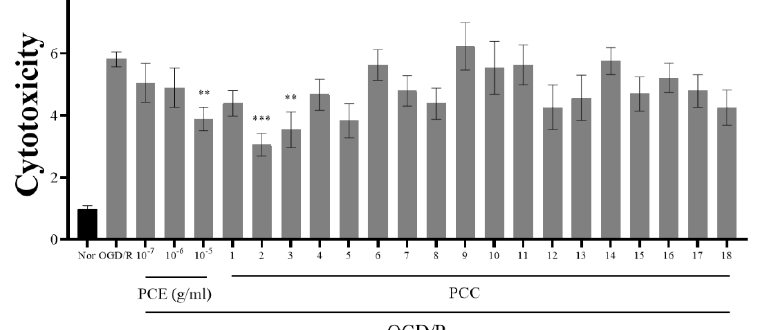
Figure 2. Reduced cytotoxicity due to PCE and PCCs from an assay of LDH release in primary neuron cells. Primary cultured mouse neuron cells were pretreated with various concentrations of PCE (10 − 7 –10 − 5 g/mL) and PCCs (10 − 6 M) for 24 h and then exposed to 2 h of OGD, followed by 24 h of reoxygenation. Cell cytotoxicity was assessed by the LDH assay (readings at 490 and 600 nm). The mean values in triplicate experiments are presented as SEM. *** p < 0.001, ** p < 0.01, compared with the Nor, determined by Tukey’s multiple comparison test following a one-way analysis of variance (Nor and OGD/R, n = 100; PCE and PCCs, n = 20).